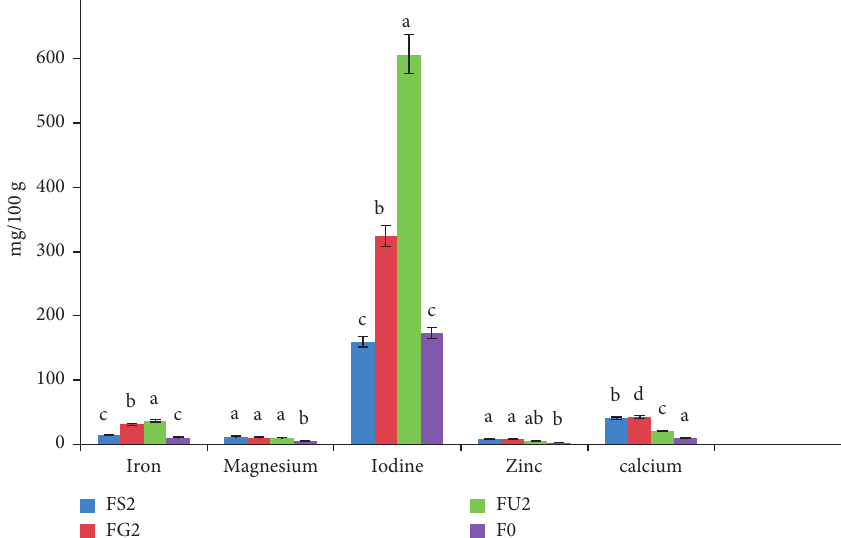
Figure 5: Mineral content of sour fruits with 3% algae powder. Different letters indicate significant differences ( p < 0 . 05 ) .